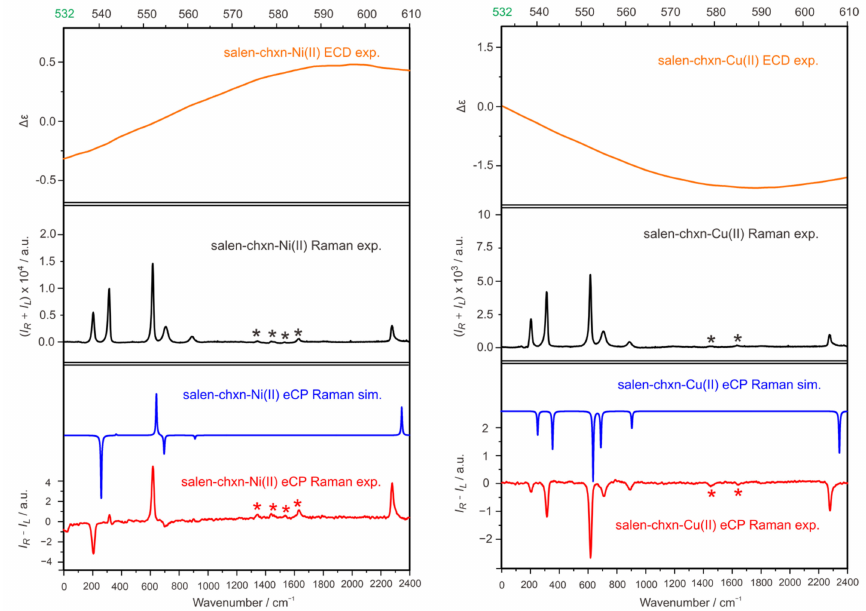
Figure 12. ( Top ): experimental ECD spectra from 532 nm to 610 nm of salen-chxn-Ni(II) and salen- chxn-Cu(II). ( Middle ): experimental Raman spectra of the two metal complexes. ( Bottom ): the comparison of the experimental and simulated eCP-Raman spectra of the two metal complexes. The solute bands are indicated with